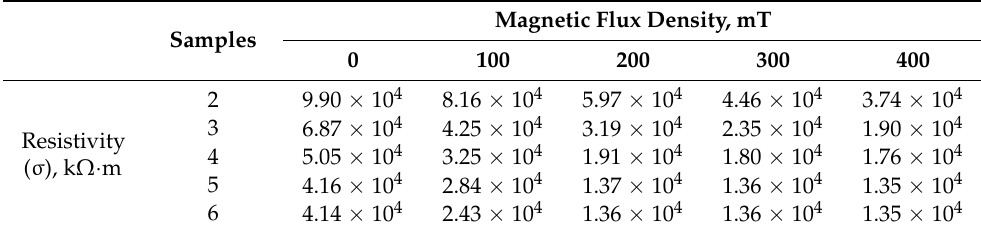
Table 4. The resistivity values for various weight percentages of